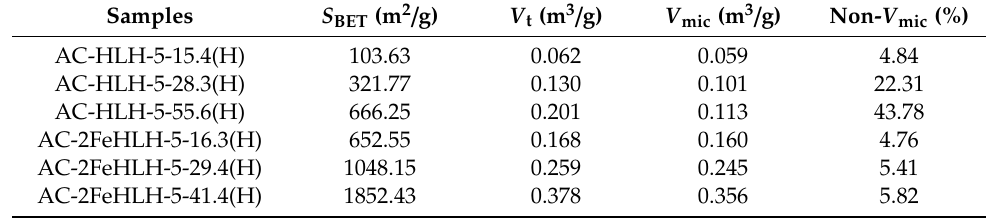
Table 5. Pore structure parameters of typical chars at di ff erent burn o ff s during activation.